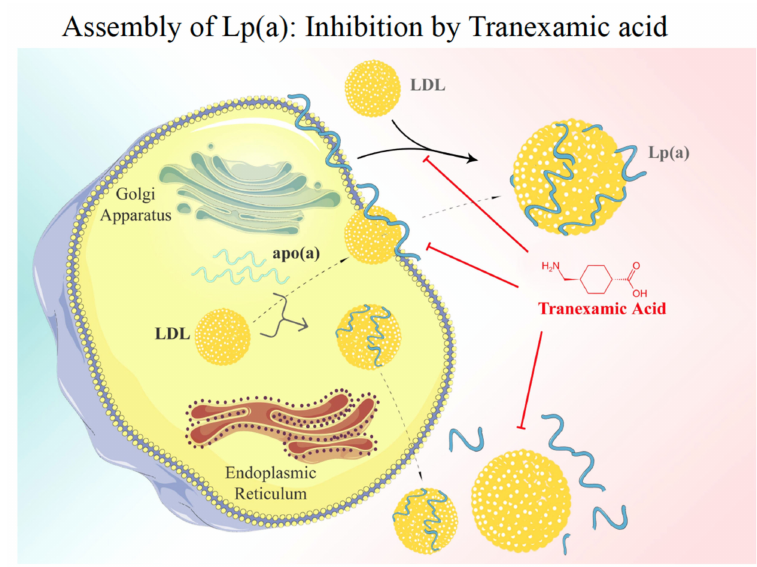
Figure 7. Lp(a) assembly. There are currently two models of Lp(a) assembly discussed: (i) apo(a) is bio-synthesized in the liver and after passage through the Golgi apparatus it binds to the surface of liver cells. Bypassing LDL then associates with apo(a) and, after linking via a disulfide bridge, the native Lp(a) is formed. The first step of assembly may be competed for by Lys analogues such as Tranexamic acid. (ii) Alternatively, the assembly of Lp(a) may take place in the liver cell [1].